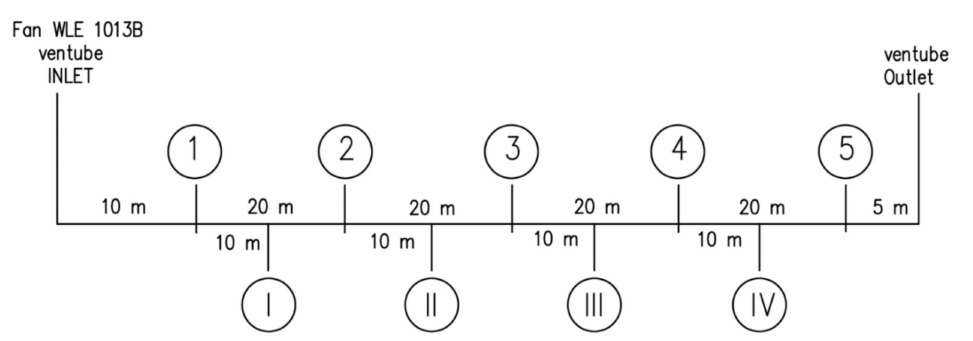
Figure 8. Arrangement of connectors on the station—stage 2.